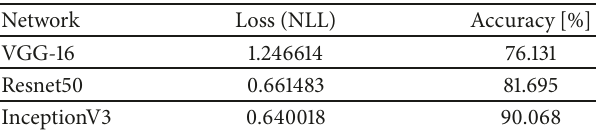
Table 4: Distracted driver posture classification results on test data with unique